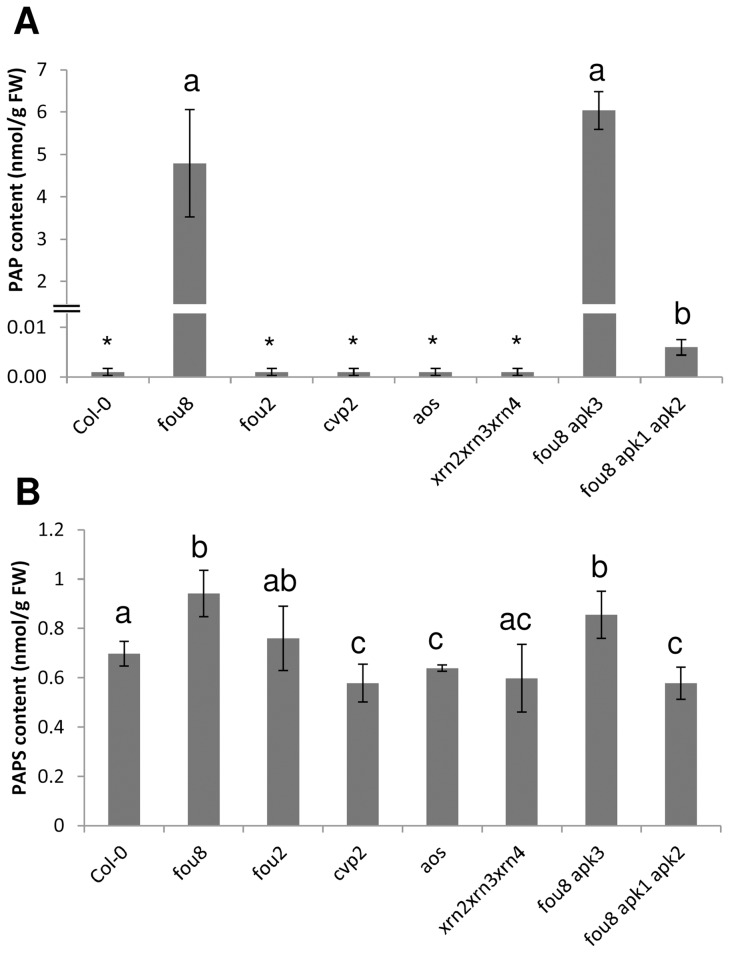
Accumulation of PAP and PAPS in fou8 related genotypes.The various Arabidopsis lines were grown for 5 weeks in controlled environment room. Leaves were harvested and the levels of A PAP and B PAPS were determined by HPLC. Results are presented as means ± SD from four individual plants, grown in two independent experiments. Asterisks represents levels under detection limit, different letters mark values significantly different at P<0.05.